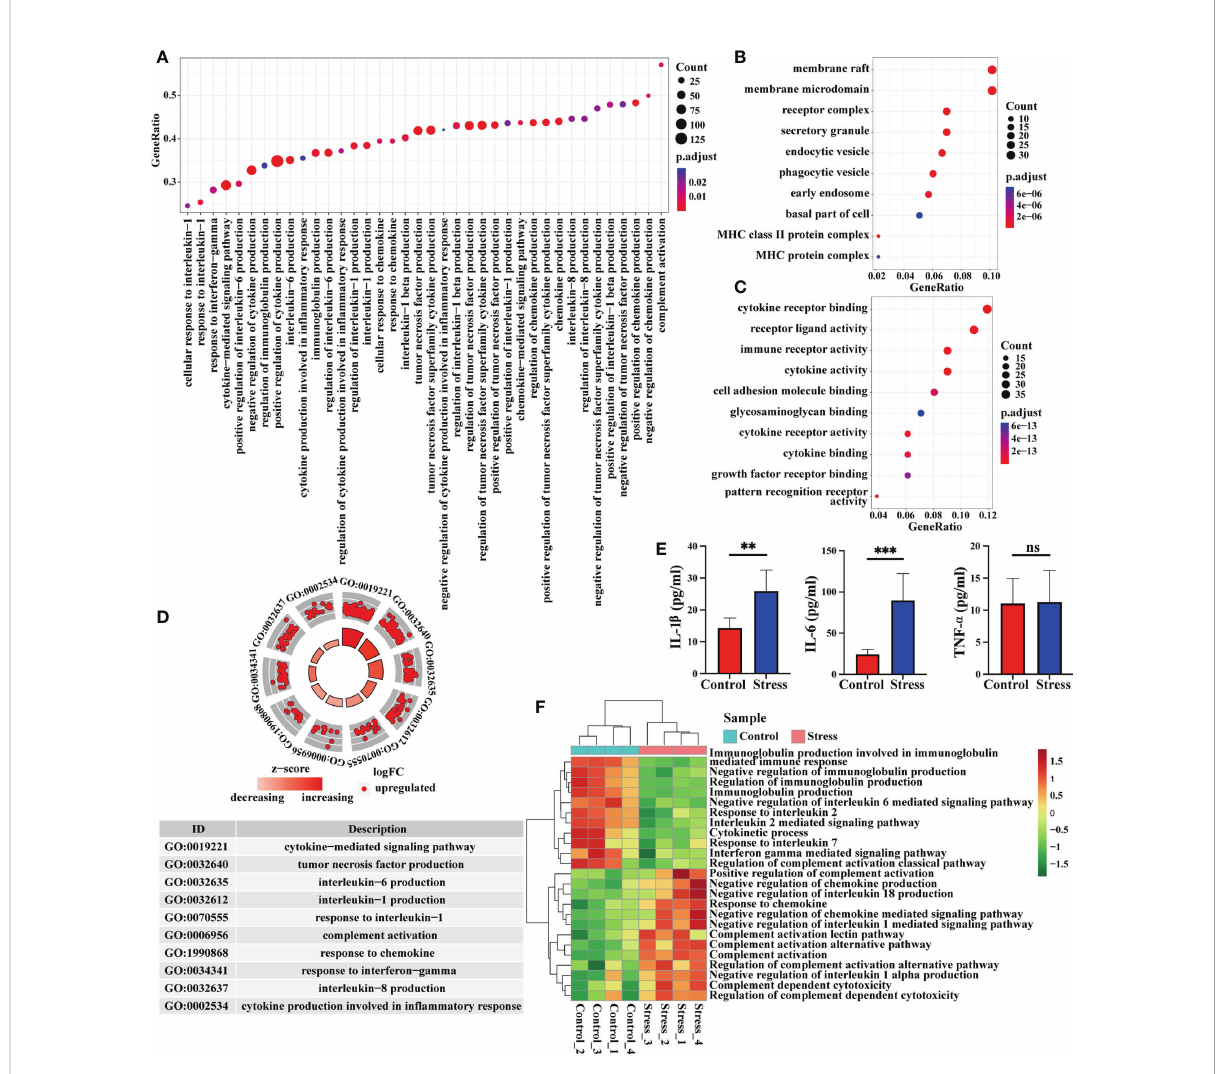
FIGURE 3 Analysis of gene expression at immune molecular level by GSEA and GSVA. (A) GO enrichment analysis of the whole transcriptome was performed by GSEA, and the biological processes represented by the gene terms were visualized at the immune molecular level. (B, C) Genes from these gene terms were selected for another GO enrichment analysis, and the top 10 CC and MF were visualized. (D) Select some important gene terms related to immune molecules, and then visualize the gene expression. (E) Concentration of serum proin fl ammatory cytokines IL-6, TNF- a and IL-1 b were detected by ELISA in mice with or without stress (n=5, per group). **P < 0.01, ***P < 0.001. Means ± SD are shown. Data shown are representative of 2 independent experiments. (F) Meanwhile, GSVA was performed on RNA-seq, and the differentially expressed gene terms were visualized at the immune molecular